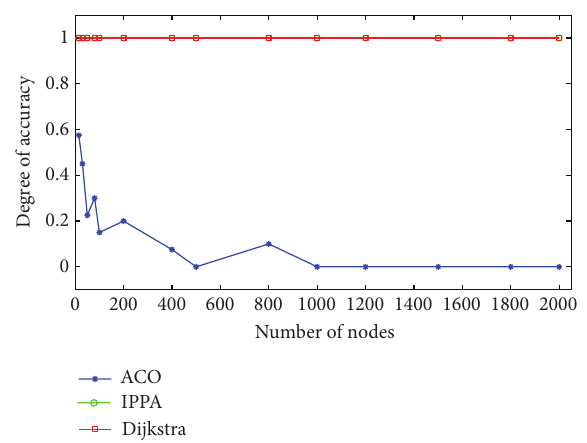
Figure 9: Comparison of accuracy on different algorithms solving the shortest path problem on randomly generated networks. ACO refers to the ant colony optimization algorithm while IPPA refers to the improved Physarum polycephalum